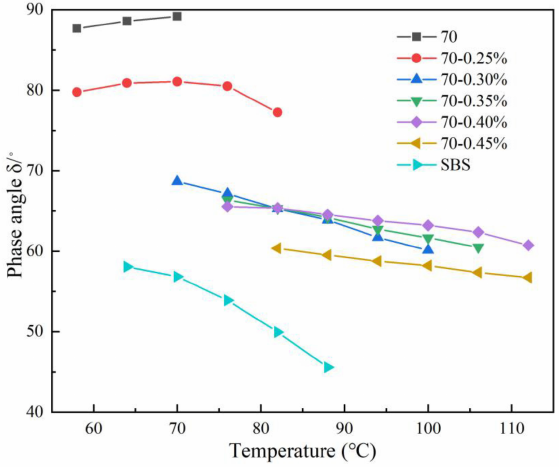
Figure 3. δ -temperature results as a function of temperature and RPCM